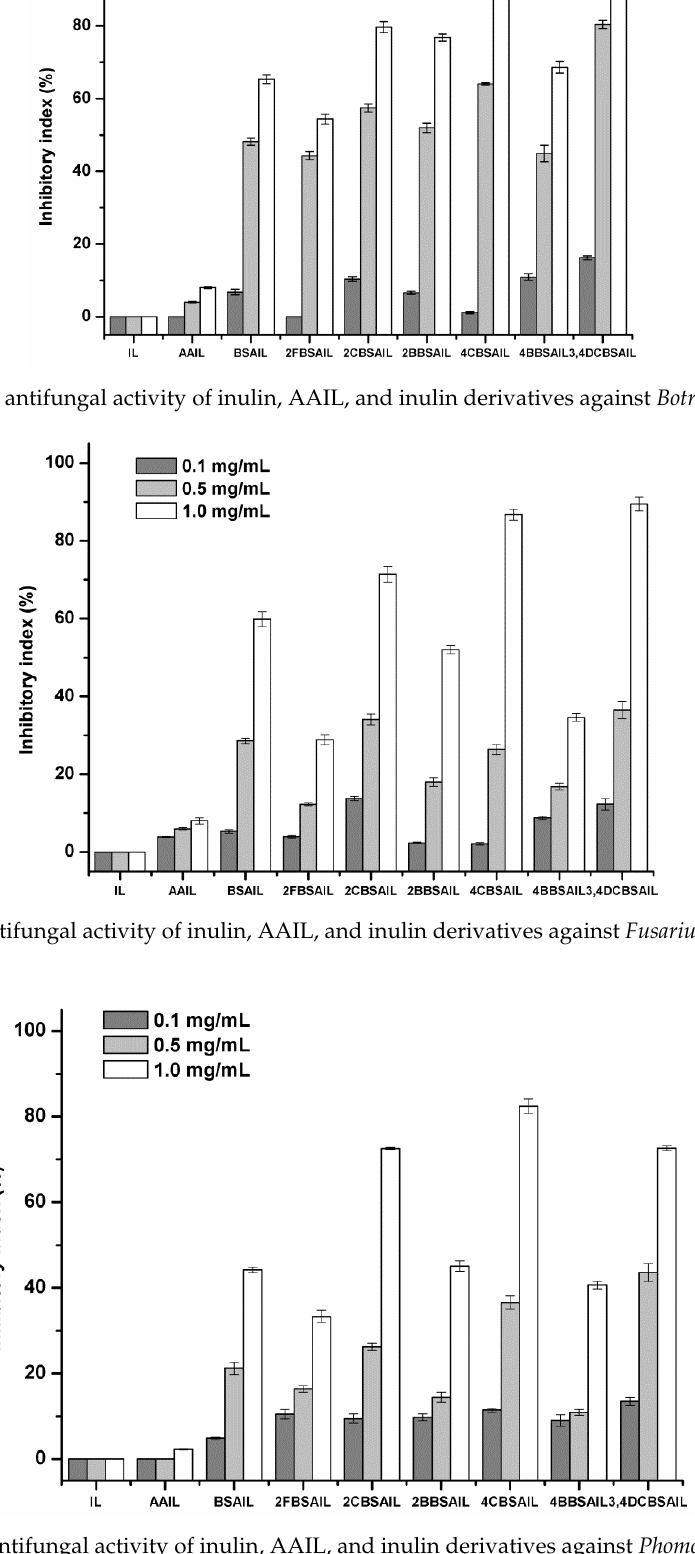
Figure 9. The antifungal activity of inulin, AAIL, and inulin derivatives against Fusarium oxysporum f. sp. cucumerium Owen. 4. Conclusions In this study, seven kinds of inulin derivatives modified by Schiff bases were successfully synthesized. Their structure characteristics were confirmed by FTIR, 1 H NMR, and 13 C NMR. The antifungal activity of these derivatives against four kinds of plant pathogens, namely, B. cinerea, F. oxysporum f. sp. cucumerium Owen, F. oxysporum f. sp. niveum, and P. asparagi , was studied by the mycelium growth rate method in vitro. Firstly, the results confirmed the feasibility of modifying inulin with Schiff bases to confer high antifungal activity to inulin. Then, we found that the type, the position, and the number of substituent groups (halogens) on Schiff bases had an effect on the derivatives ’ antifungal activity. The halogens could have a synergistic effect, as they exhibited a